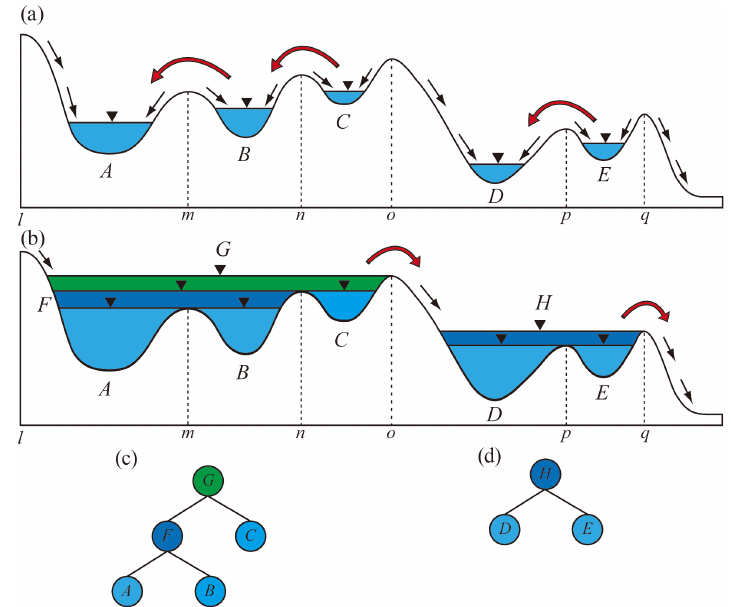
Figure 4. Illustration of the filling-merging-spilling dynamics of wetland depressions: (a) first-level depressions, (b) nested hierarchical structure of depressions under fully filled condition, (c) corresponding contour tree representation of the composite wetland depression (left) in (a) , and (d) corresponding contour tree representation of the composite wetland depression (right) in (a) . Different color of nodes in the tree represents different portions of the composite depression in (a) : light blue (first-level), dark blue (second-level), and green